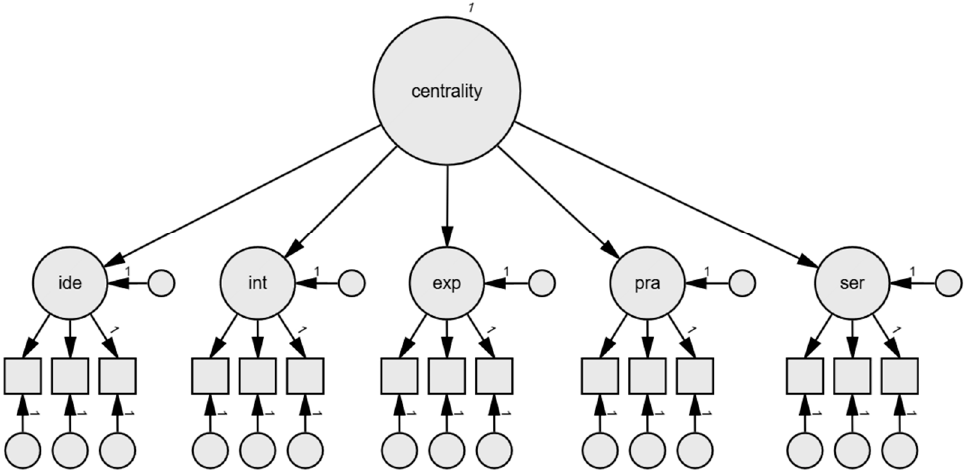
Figure 2. Symbolic picture of centrality or religiosity as a second-level factor with the 5 dimensions of the CRS. Small circles depict residual variances, squares depict indicators. “int”—intelligence, “ide”—ideology, “exp”—experience, “pra”—private practice, “ser”—church attendance. Small circles depict residual variances, squares depict indicators, curved lines show covariances, straight lines show regressions.